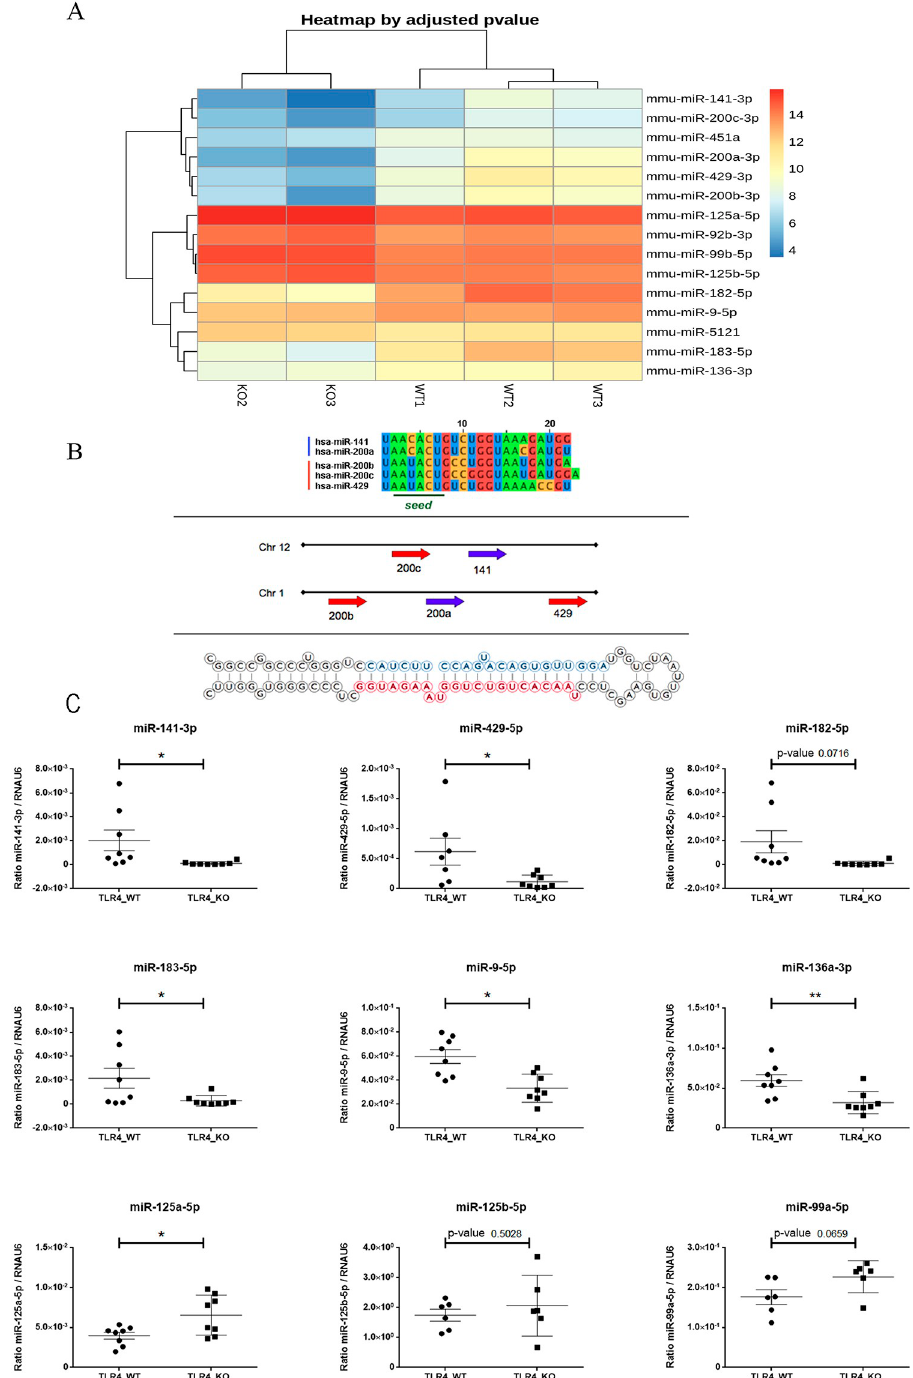
Fig 4. Differential expression pattern between the TLR4 and TLR4-KO mice: ( A ) Heatmap diagram of the comparative TLR4 vs . TLR4-KO mice. ( B ) Sequence of the five miR-200 family members with the human genomic localization of two clusters containing miR-200 family members; http://atlasgeneticsoncology.org/Genes/GC_MIR141. html. ( C ) RT-qPCR shows the expression of some mature miRNAs selected in WT and TLR4-KO (miR-141-3p, miR429-5p, miR-182-5p, miR-136-3p, miR-9-5p, miR-125a-3p, miR-125b-5p, miR99a-5p) (n = 6–8). The statistical analysis was performed by the Test-t-. Statistical significance is denoted by a p-value of < 0.05.